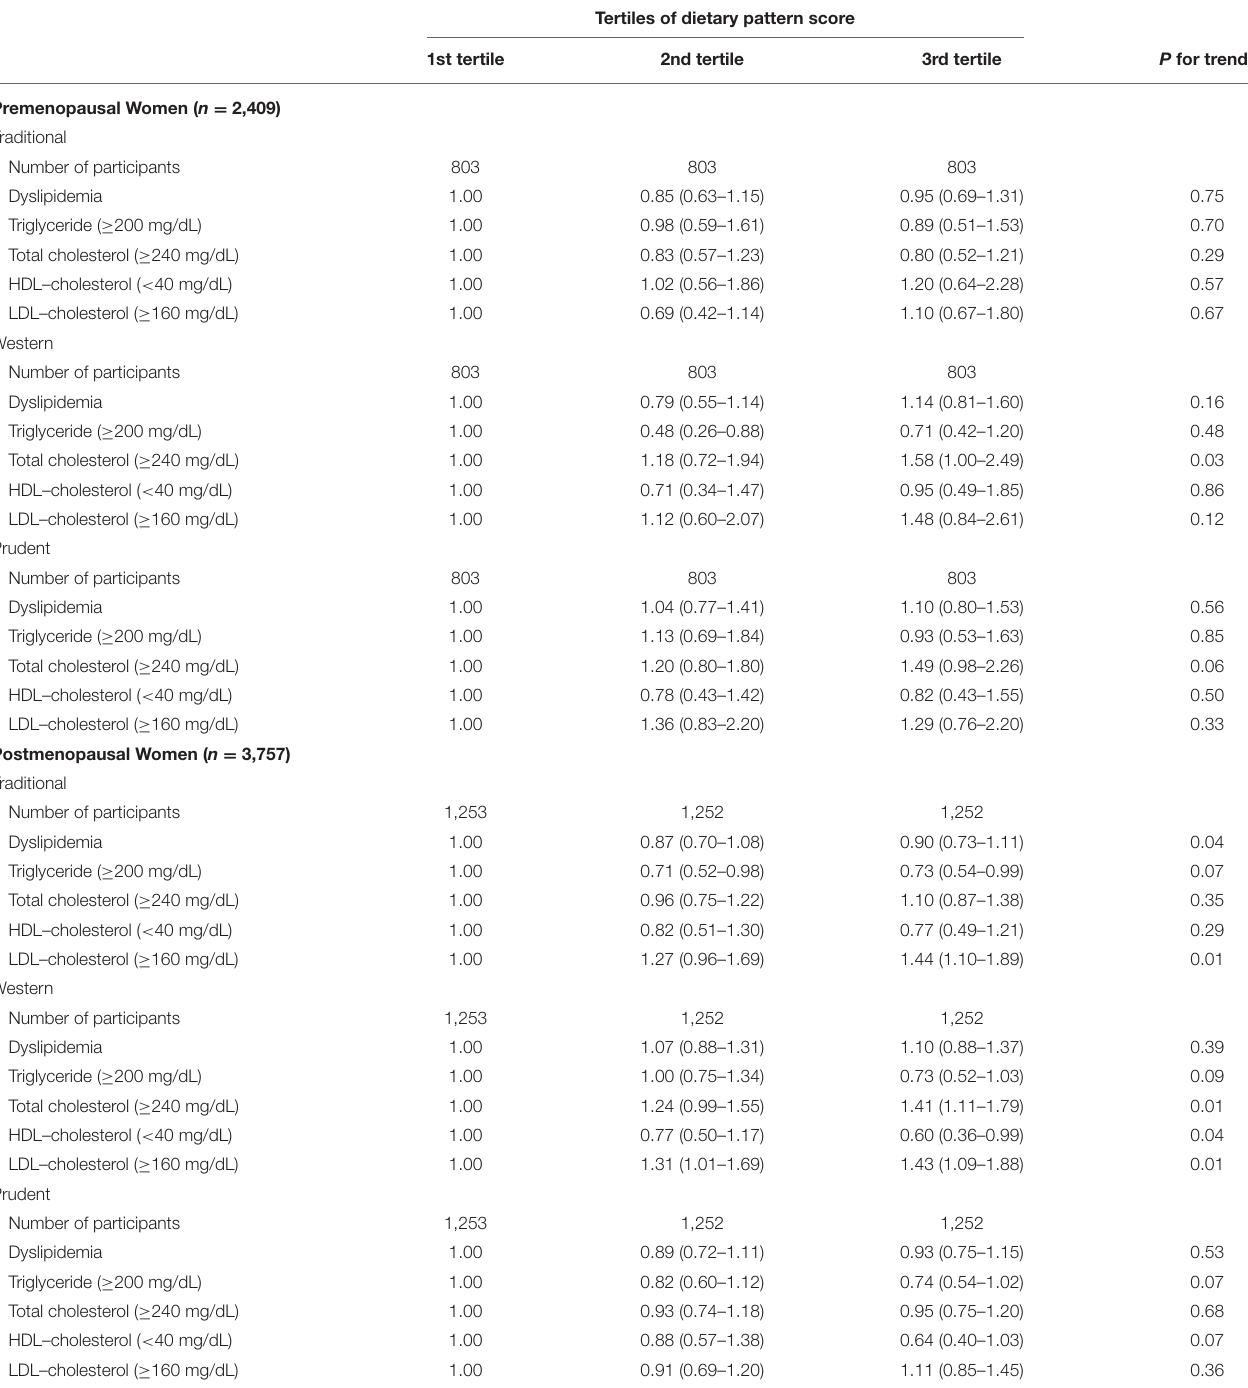
TABLE 6 | Odds ratios and 95% confidence intervals for the association between tertiles of dietary pattern score and the dyslipidemia and its components by menopausal status. Tertiles of dietary pattern score 1st tertile 2nd tertile 3rd